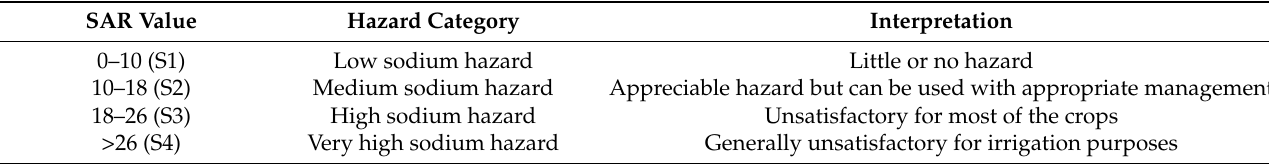
Table 7. Sodium hazard zones: based on